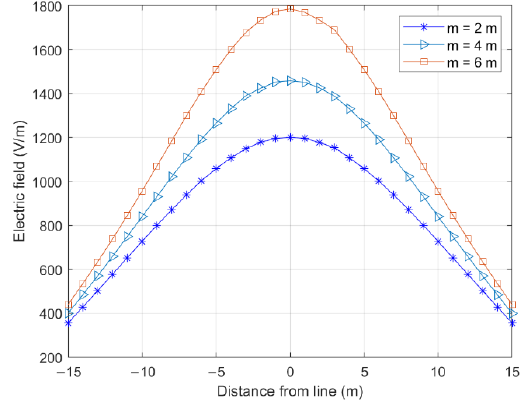
Figure 16. Effect of height difference on electric field of tower position.